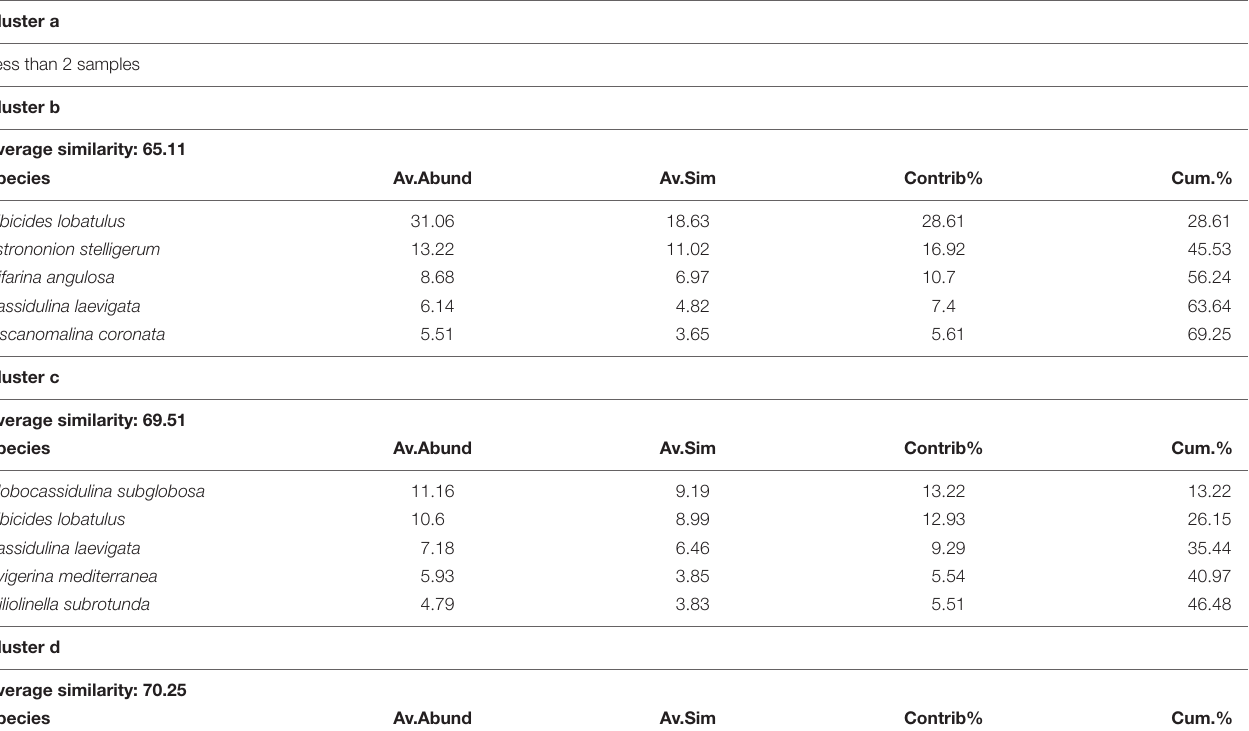
TABLE 5 | List of the 5 most contributing species to the similarity within clusters b, c, d, e and f, which separate at 62% similarity on the hierarchical cluster analysis ( Figure 5 ). Cluster a Less than 2